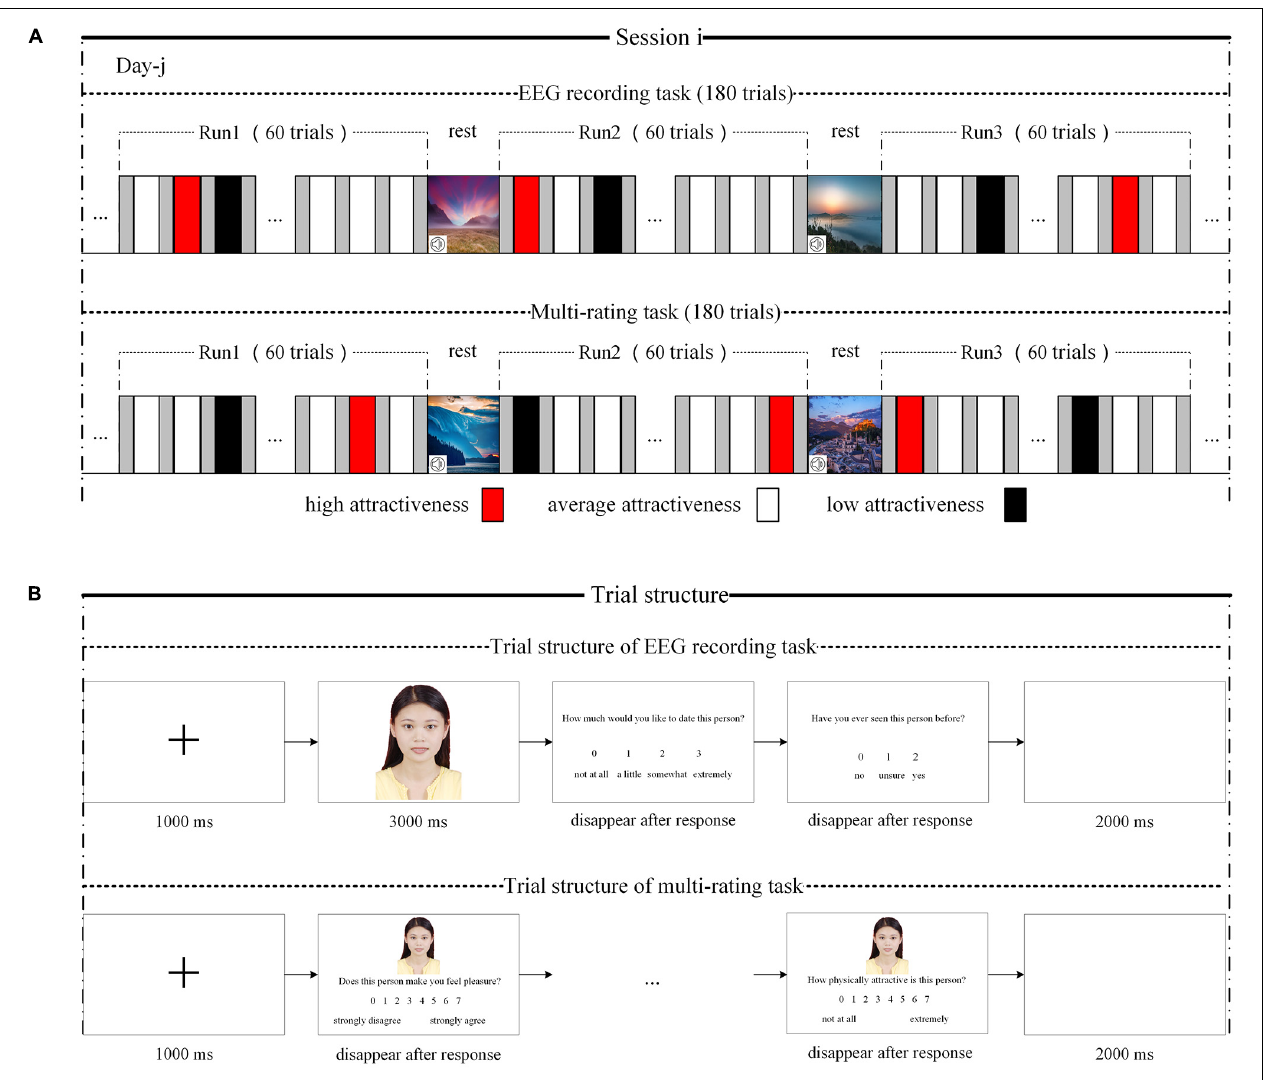
FIGURE 1 | Experimental paradigm and trial structure. (A) Experimental paradigm. The upper part is the paradigm of EEG recording task, and the bottom part is the paradigm of multirating task. (B) Trial structure. The upper part is the trial structure of EEG recording, and the bottom part is the trial structure of multirating